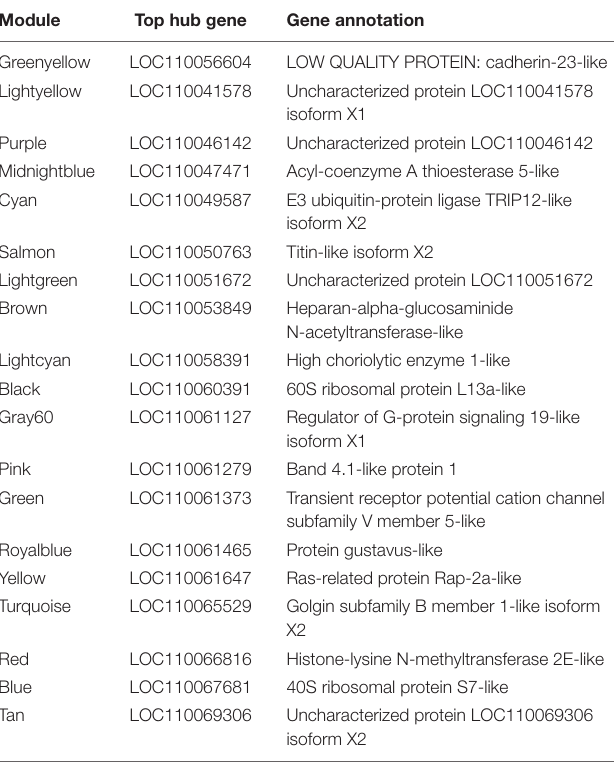
TABLE 3 | Hub genes of the 20 modules identified as having the highest module membership as defined by eigengene correlation values. Module